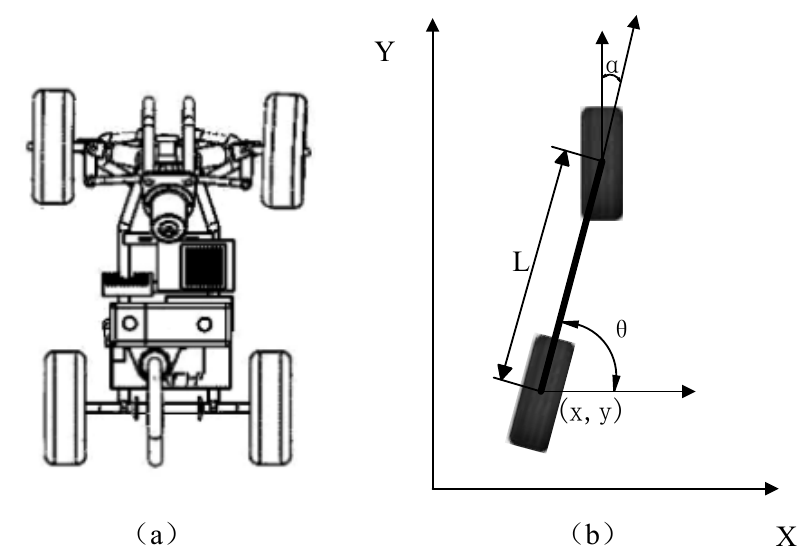
Figure 2. Mobile platform model and simplified model for kinematics. ( a ) Mobile platform model; and ( b ) simplified model for kinematic.